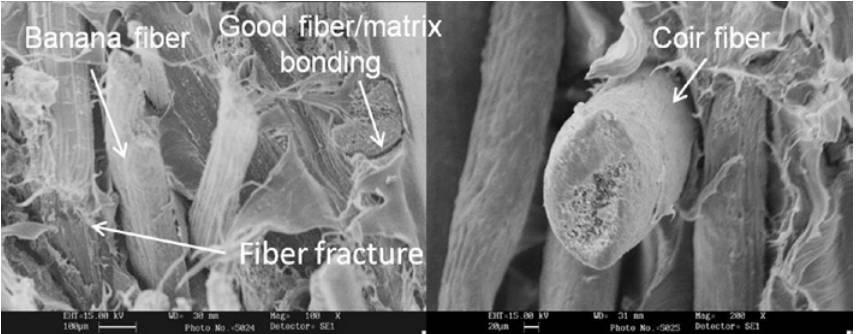
Figure 10: SEM micrograph of the tensile fracture surface of sample S3 at × 100 and × 200